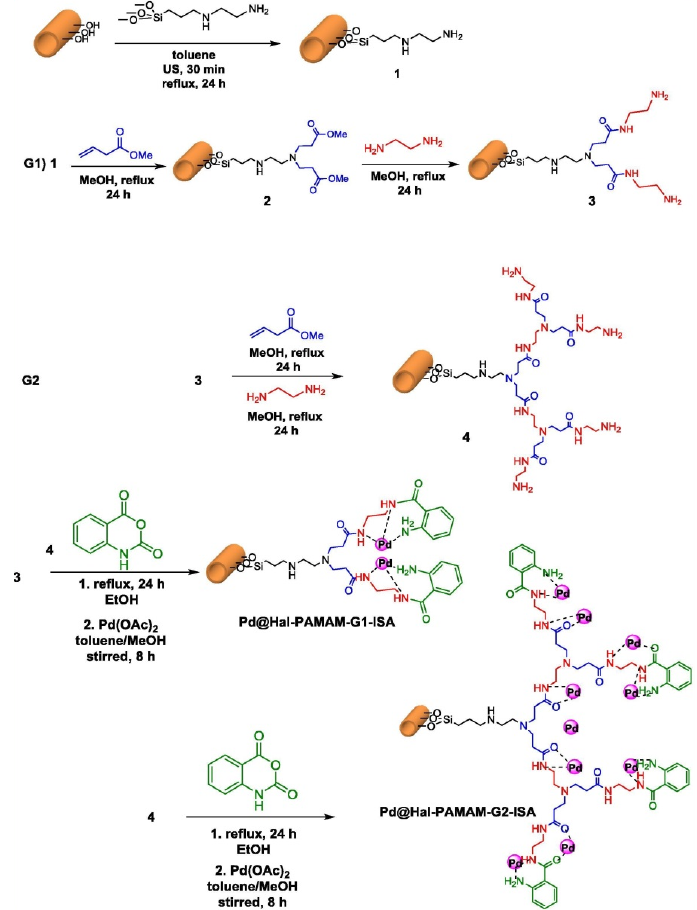
Figure 20. General procedure for the synthesis of the Pd@HNTs-PAMAM-ISA. Reproduced with permission from [161].